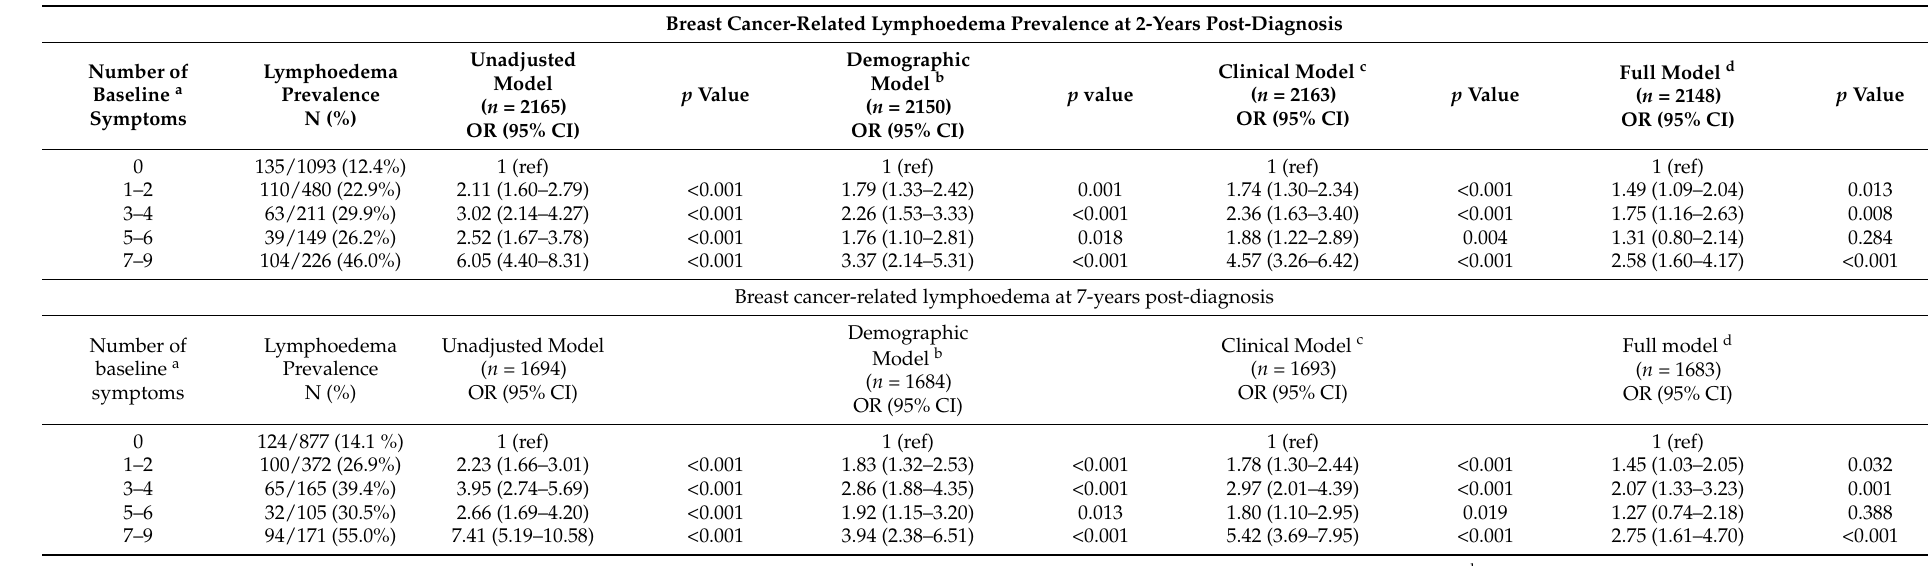
Table 5. Prevalence of breast cancer-related lymphoedema and odds ratio of lymphoedema at 2- and 7-years post-diagnosis breast cancer for those with 0, 1–2, 3–4, 5–6, 7–9 upper-body symptoms (of at least moderate severity) at the baseline among women in the Carolina Breast Cancer Study, Phase III. Breast Cancer-Related Lymphoedema Prevalence at 2-Years